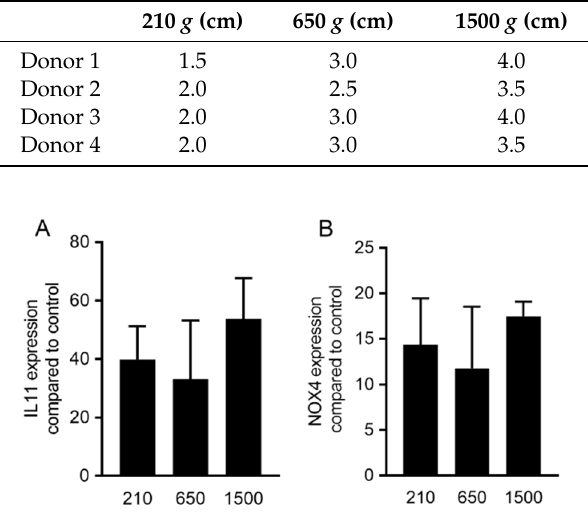
Table 1. The size of platelet-rich fibrin (PRF) membranes prepared at different g -forces are listed below in cm.